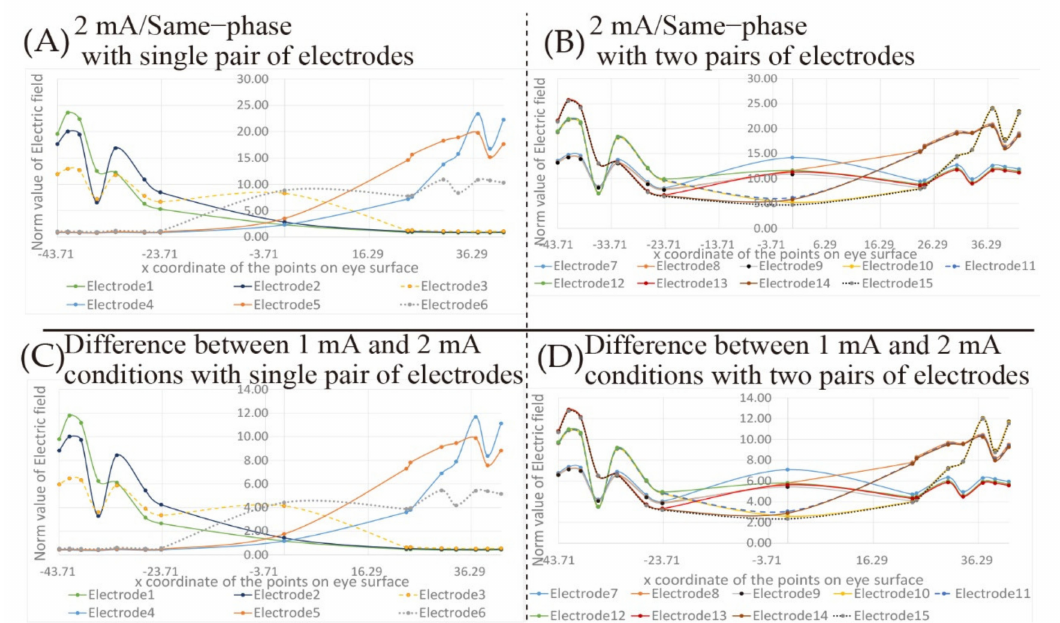
Figure 8. The transition of the electric field value on the eyeball surface with the electrode placement that is gradually separated from each other in 2 mA; ( A ) norm value of electric field in 2 mA and same-phase stimulus with single pair of electrodes; ( B ) norm value of electric field in 2 mA and same-phase stimulus with two pairs of electrodes; ( C ) difference of norm value of electric field in same-phase with single pair of electrodes between 1 and 2 mA conditions; ( D ) difference of norm value of electric field in same-phase with two pairs of electrodes between 1 and 2 mA